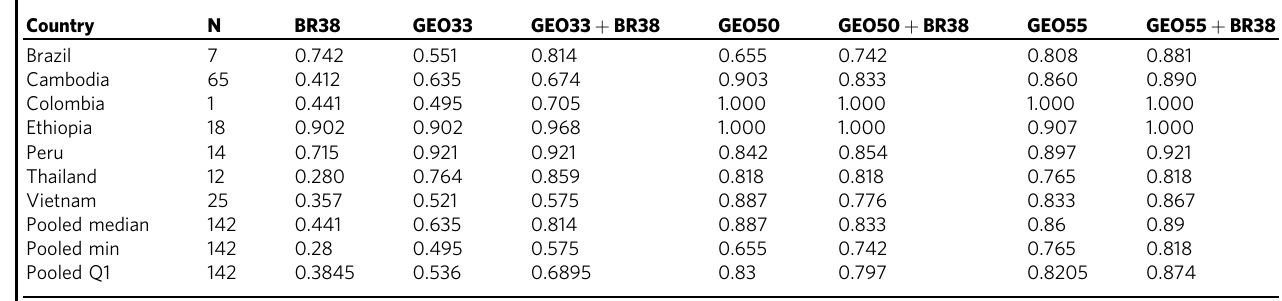
Fig. 3 Comparison of country prediction performance between the SNP panels with simulated missing data. MCC scores generated from 250 repeats with n = 25 biologically independent samples per country with no (0%) missing data ( a ) and simulating missing data (genotype fails) of 10% ( b ), 20% ( c ) and 30% ( d ); median and min re fl ect the respective summary statistics for the pooled MCC scores across all countries. Each bar presents the median, interquartile range and min and max MCC for the given country and model. With missing data, the combined BR38 and GEO panels (i.e., BR38 + GEO33, BR38 + GEO50 and BR38 + GEO55) demonstrated better results than the single panels in retaining prediction performance, likely owing to moderate levels of redundancy between some of the SNPs. Table 2 Summary of MCC scores in the independent validation